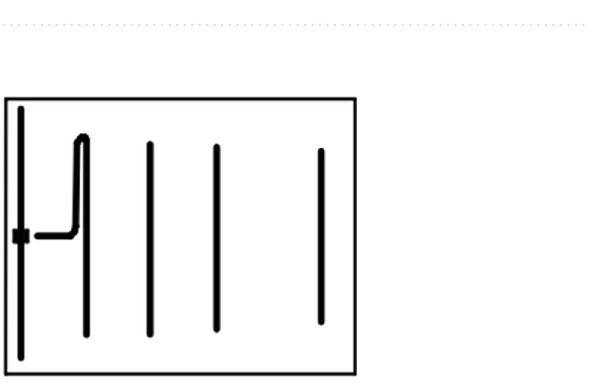
Table 2. Measurements of SNR for the two versions of Osseus .